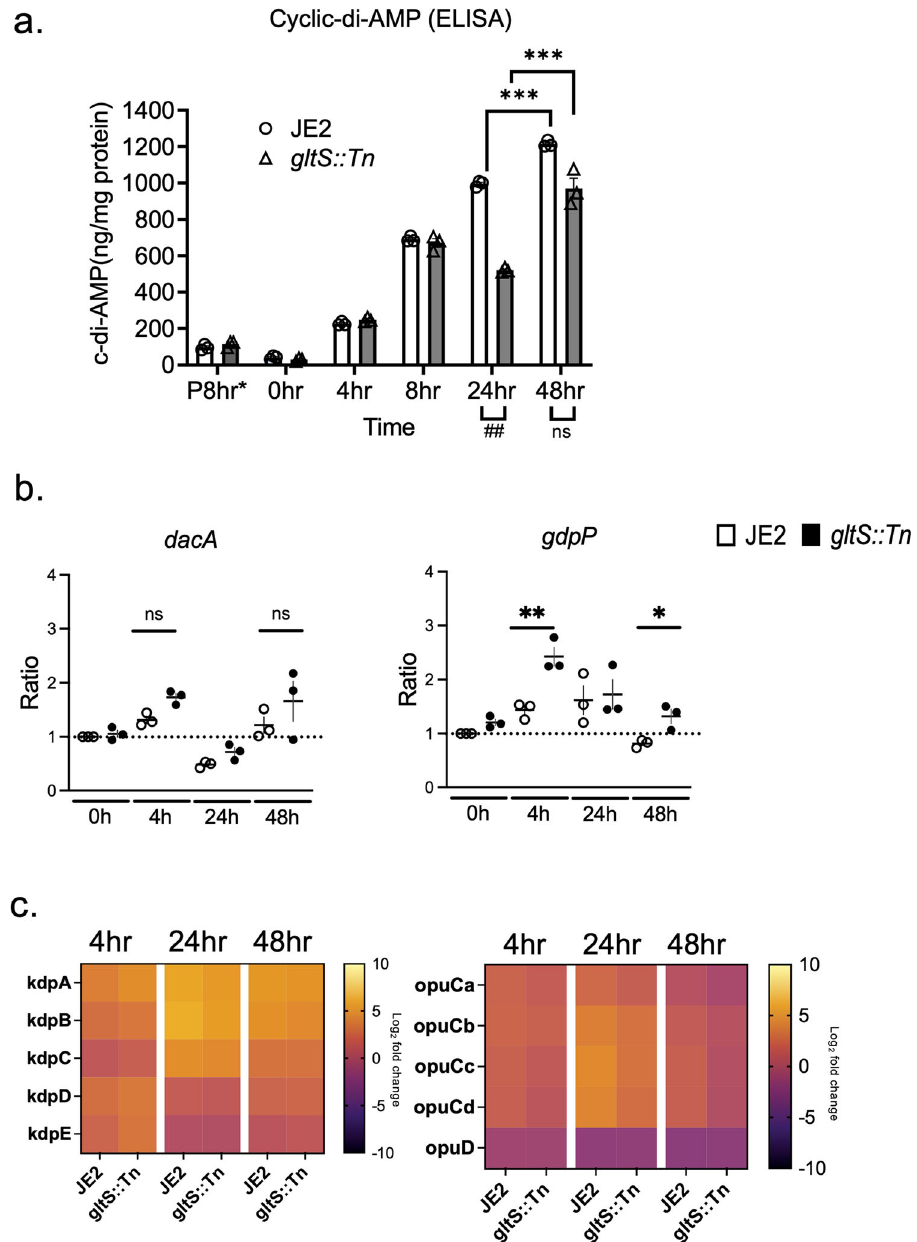
Fig. 7 Intracellular c-di-AMP levels and relative expression of genes related to c-di-AMP. a Intracellular cyclic-di-AMP levels measured by ELISA. Data are shown as mean ± SD of 3 replicates. Student t-test was used. *** p < 0.001. * P 8 h indicates 8 h after starting planktonic culture. b Gene expression ratio of dacA and gdpP by RT-qPCR. Data are mean ± SD of 4 replicates. Student t-test between strains of samples harvested at the same time. * P < 0.05, ** p < 0.01. c Heatmap of RNA seq results for kdp and opu operons. Log 2 fold change from expression at time 0 for each gene. The bar indicates log 2 fold change at each time point referenced to the start of bio fi lm culture (0